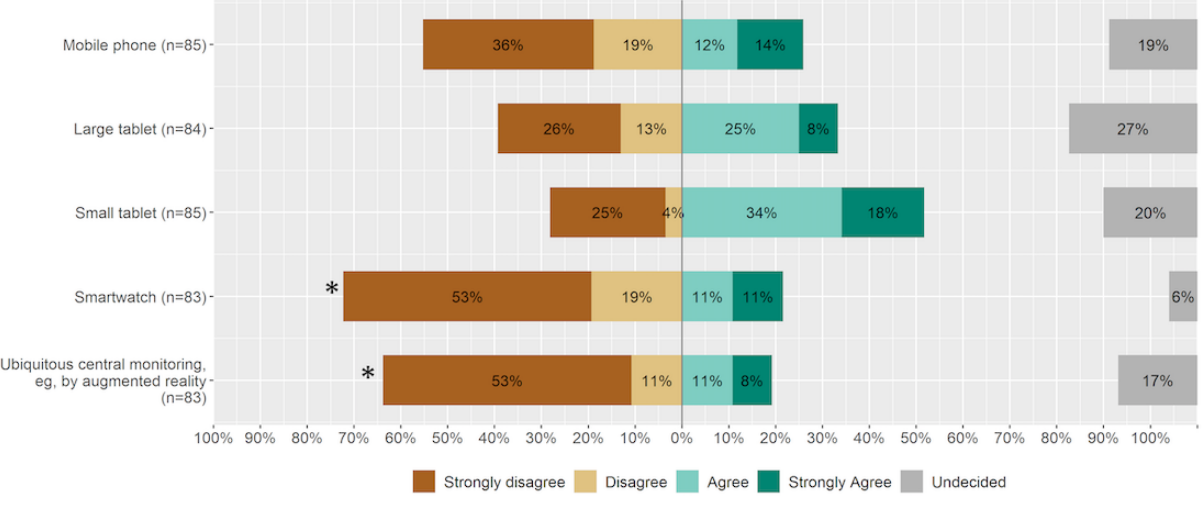
Figure 4. Suggestions for remote patient monitoring display devices in intensive care medicine for usage on hospital premises. An asterisk indicates statistical